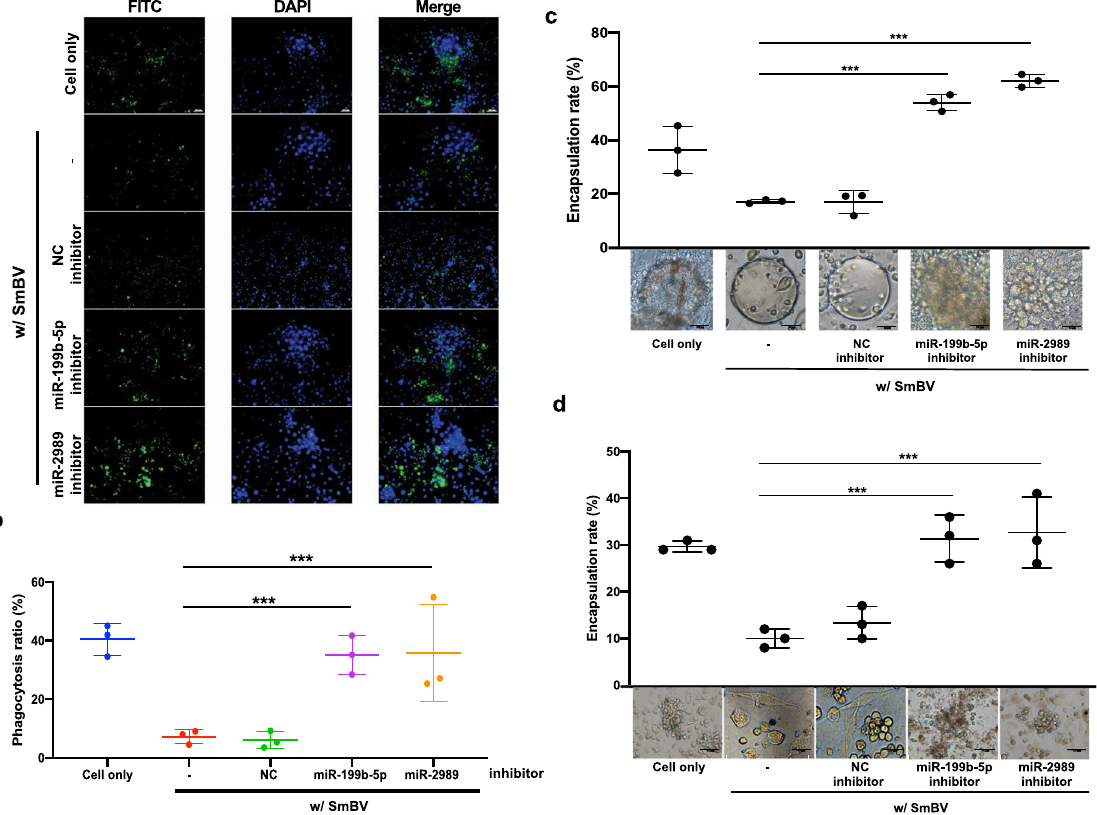
Fig. 3 Inhibition of SmBV miRNA expression increases cellular immune responses in S. litura . Third-instar S. litura larvae were injected with SmBV and miR-199b-5p or miR-2989 inhibitor; hemocytes were extracted 36 h after the microinjection. a The hemocytes were mixed with FITC-labeled E. coli and the phagocytosis activity of hemocytes was determined by green fl uorescence emitted from the ingested E. coli . b The phagocytosis ratio (%) was derived from the proportion of FITC to DAPI; FITC can be seen as green fl uorescence detected from FITC-labeled E. coli and DAPI can be seen as blue fl uorescence detected from stained hemocytes. (The p -value of miR-199b-5p inhibitor: 0.00548445 and miR-2989 inhibitor: 0.04668200). c Encapsulation assay determining binding of multiple hemocytes to the Sephadex A-25 beads added in the cell culture. The encapsulation rate was calculated by KP assay. Bottom: representative images of one of the Sephadex A-25 beads added in each cell culture. (The p -value of miR-199b-5p inhibitor: 0.00078001 and miR- 2989 inhibitor: 0.00019559). d Encapsulation of C.elegans in the hemocoel of S. litura . 24 h after injection, encapsulated nematodes were recovered from S. litura . (The p -value of miR-199b-5p inhibitor: 0.00491668 and miR-2989 inhibitor: 0.00416911) NC inhibitor: negative control inhibitor. All experiments were performed with eight biological replicates ( n = 8). Data are expressed as the mean and standard deviation (SD). p -values were calculated using Student ’ s t -test (* p < 0.05; ** p < 0.01; *** p <